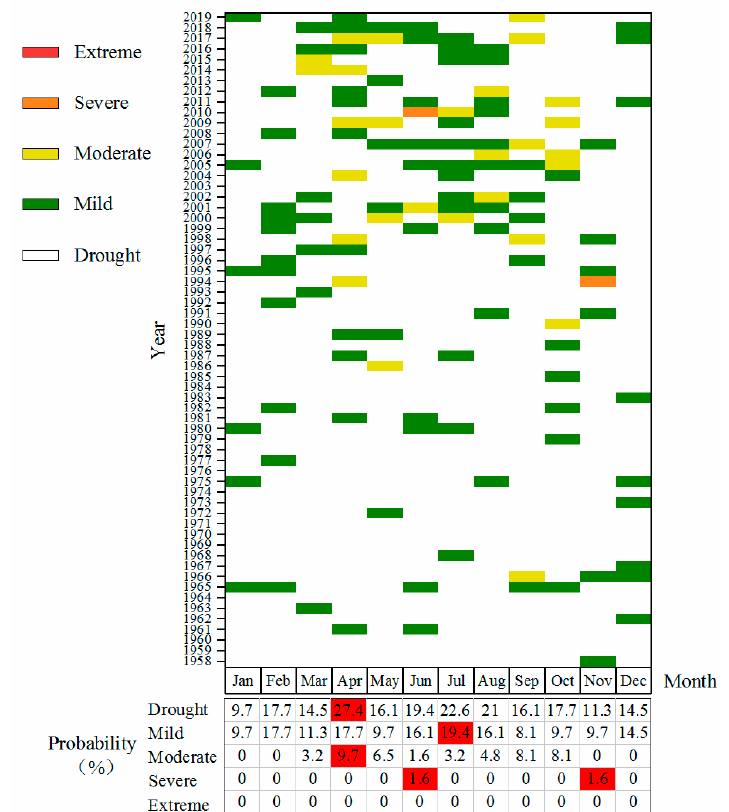
Figure 8. Intra-annual distribution and frequency of droughts.